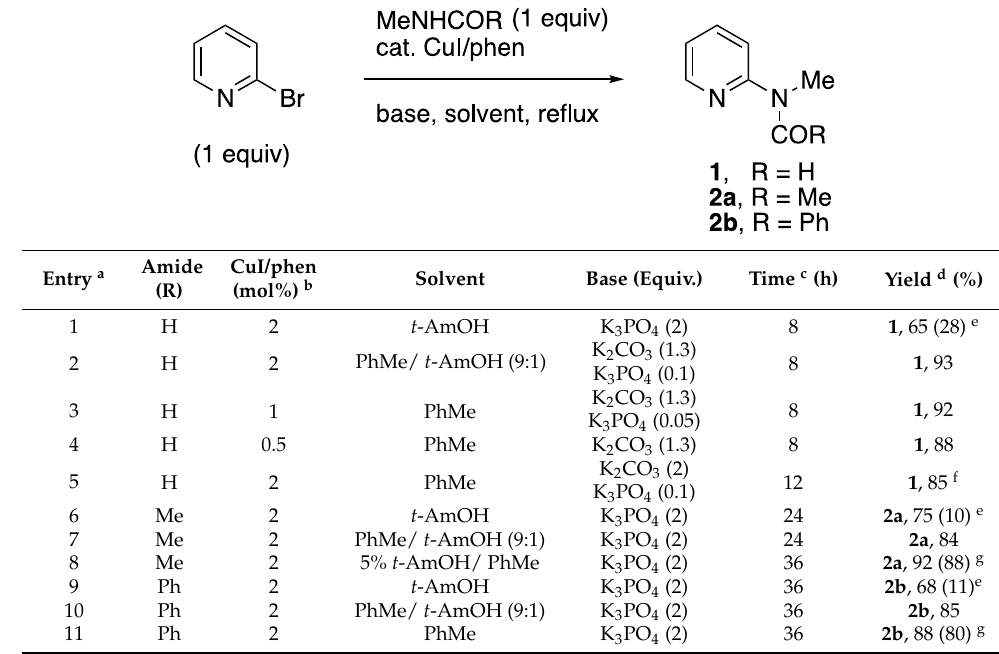
Table 1. Goldberg reactions of 2-bromopyridine and secondary amides.